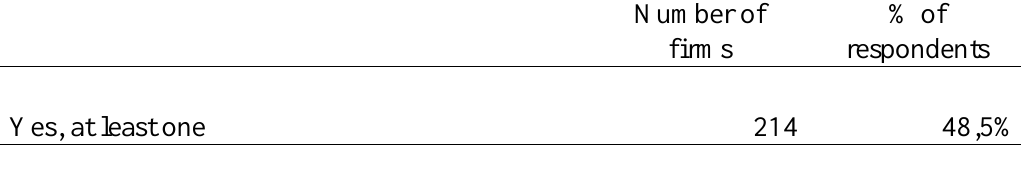
Table 2: The Importance of Innovation 4.0 in the Automotive Sector.